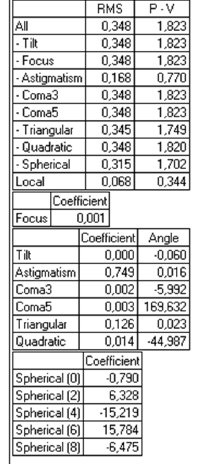
Fig.4. Parameters of the required